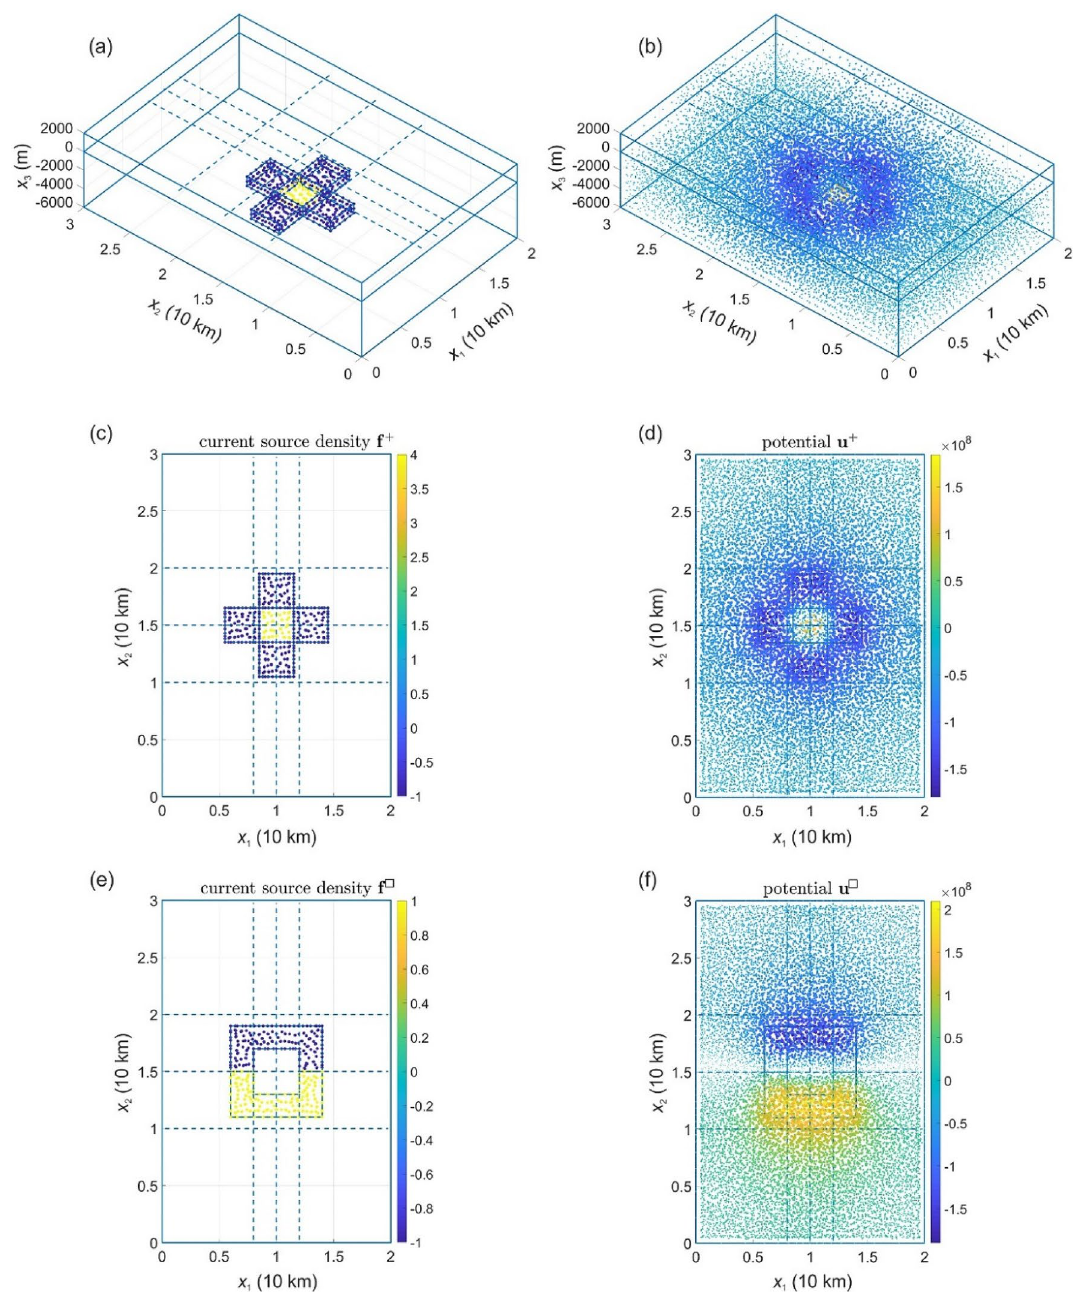
Figure 2. Electric potentials generated by two current source densities. The perspective view ( a ) and top view ( c ) of the current source density f + ; the perspective view ( b ) and top view ( d ) of the electric potential u + generated by the current source density. Top view of the electric potential u in Figs. 3, 4, 5, 6, a top view image presents a transparent projection of physical quantities at finite element nodes on the plane. The size of the nodes in the images is proportional to the absolute value of the physical quantities it represents, i.e. the nodes with zero-values are not displayed. Dashed lines show the position of the paths, along which synthetic measurements of the electric potential have been M is the squared matrix consisting of 0 (no measurement) or 1 (a measured value of u exists); and the notation A := B means that A equals B by a definition. Using Eq. (3), we obtain: